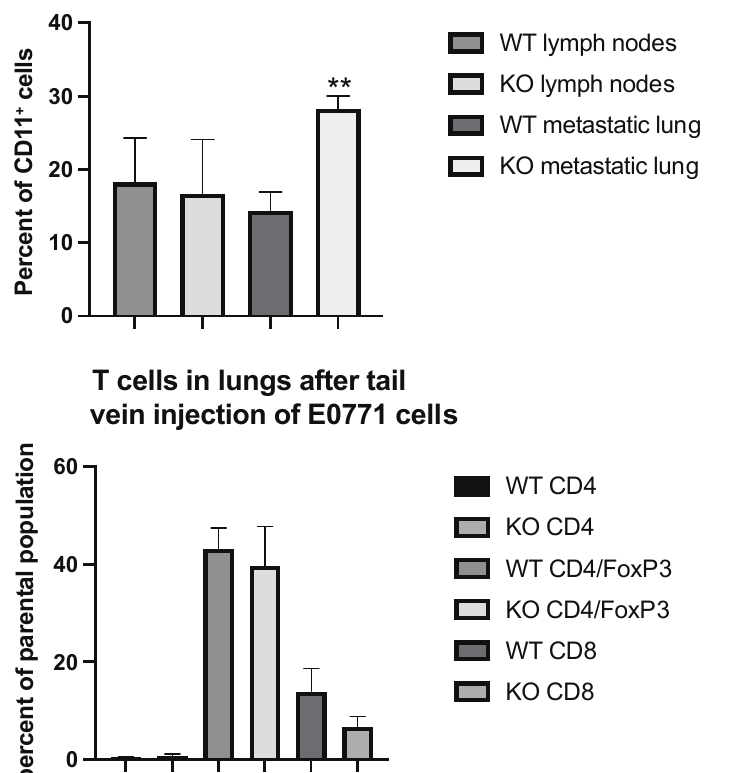
Figure 4. Immune cell profiling of lung areas with dense tumor cell colonization from wild type (WT)